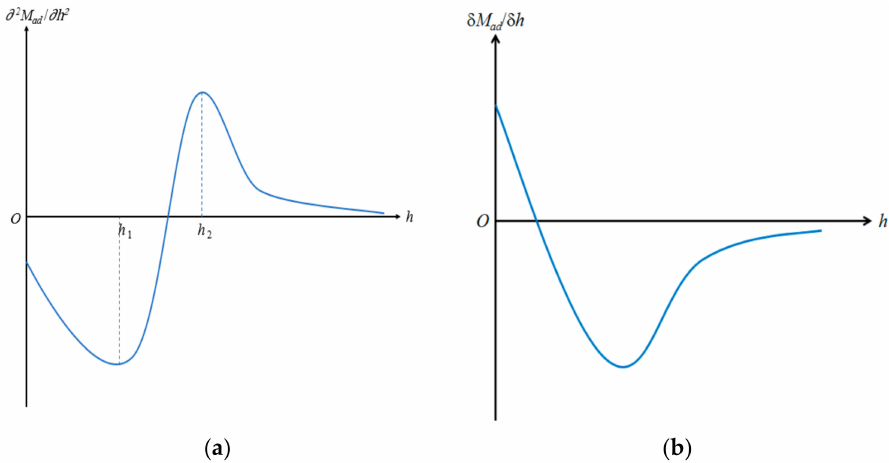
Figure 1. Sketch map of the derivatives: ( a ); ∂ 2 M ad / ∂ h 2 , ( b ) δ M ad / δ h